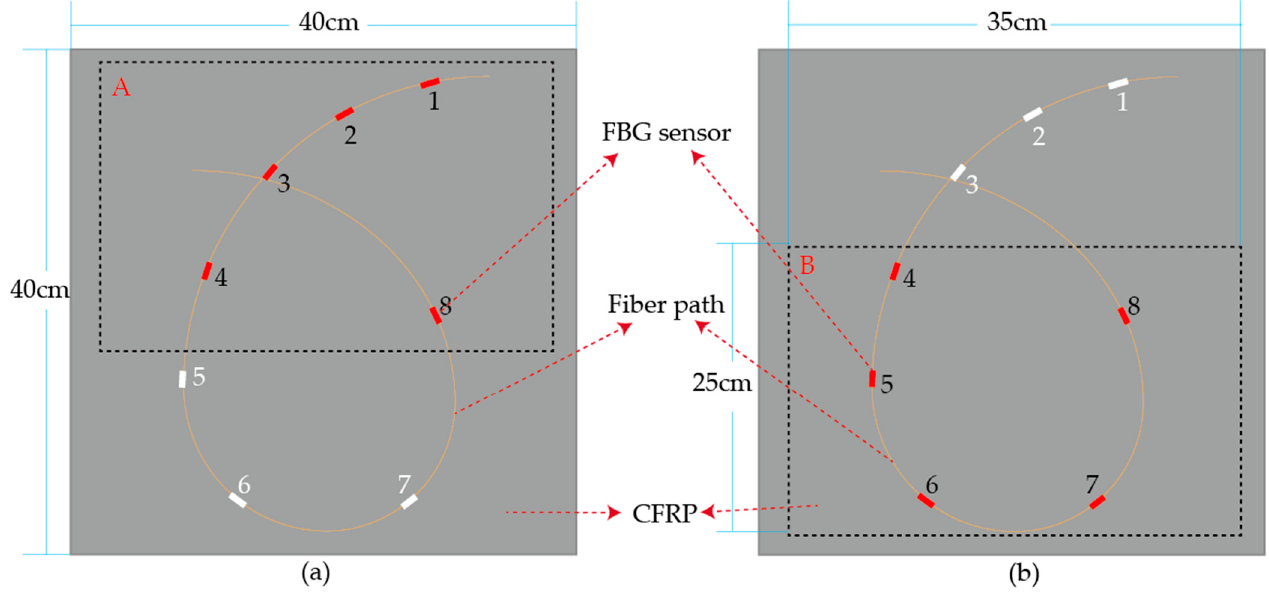
Figure 15. ( a ) Five FBG sensors with a close arrangement in group A; ( b ) five FBG sensors with a spaced-out arrangement in group B.